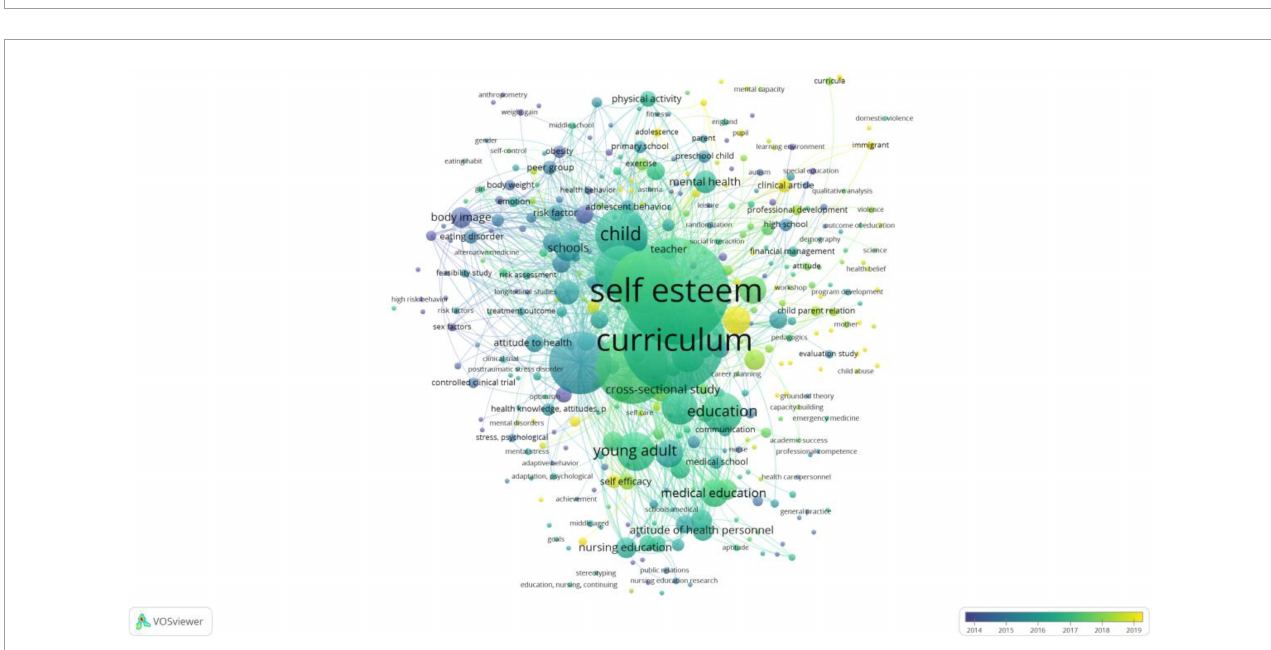
FIGURE7 Co-occurrence networks of research themes based on index